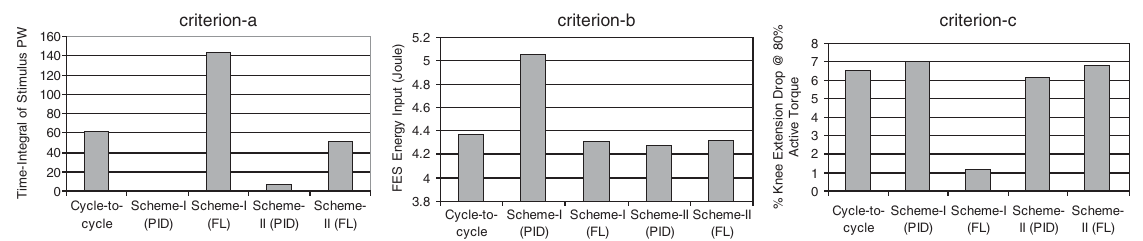
Fig. 21. Fatigue resistance of the SBO control approaches compared based on 3